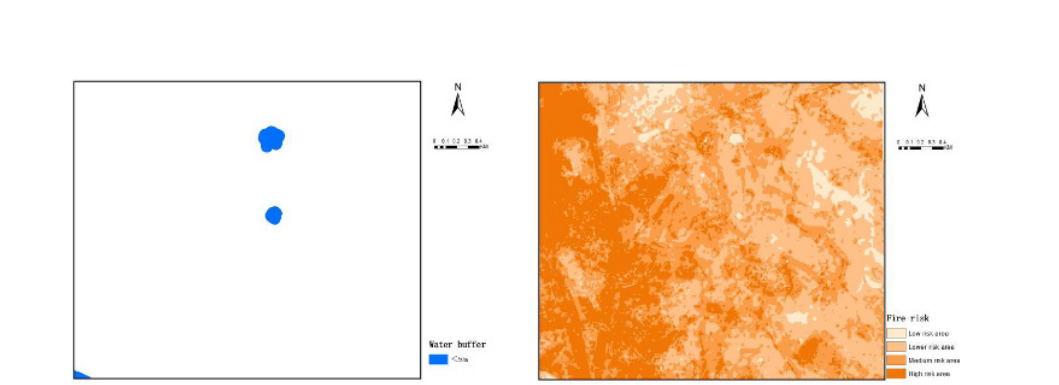
Fig. 9. Water buffer factor level. Fig. 10. WUI fire risk level